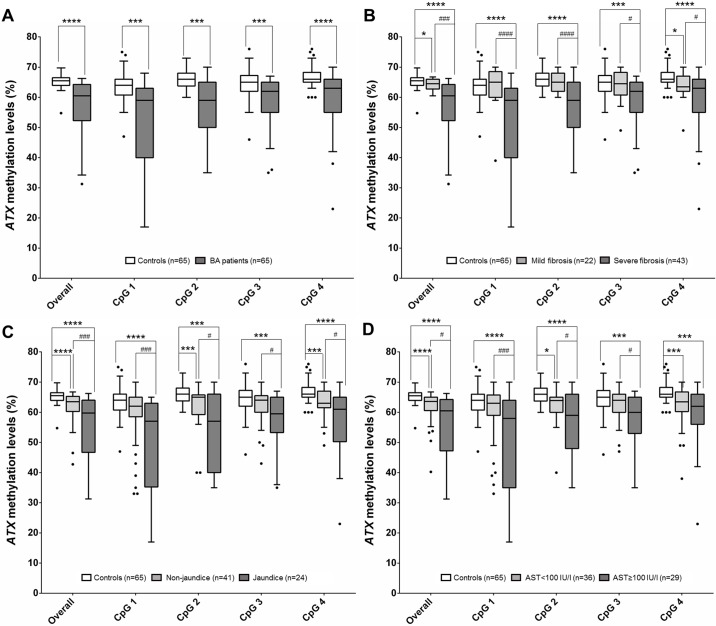
Box-plot illustrating methylation levels of the ATX promoter in peripheral blood leukocytes of subjects among different groups.(A) Methylation levels of the ATX promoter at four CpG sites in BA patients and healthy controls. (B) Methylation levels of ATX promoter at four CpG sites in BA subgroups, including mild fibrosis (F0-F2) and severe fibrosis (F3-F4). (C) Methylation levels of the ATX promoter at four CpG sites in patients with and without jaundice. (D) Methylation levels of ATX promoter at four CpG sites in BA patients according to severity of hepatic damage (AST values). *P<0.05, **P<0.01, ***P<0.001, ****P<0.0001 vs control group and #P<0.05, ##P<0.01, ###P<0.001, ####P<0.0001 for comparisons between BA subgroups.